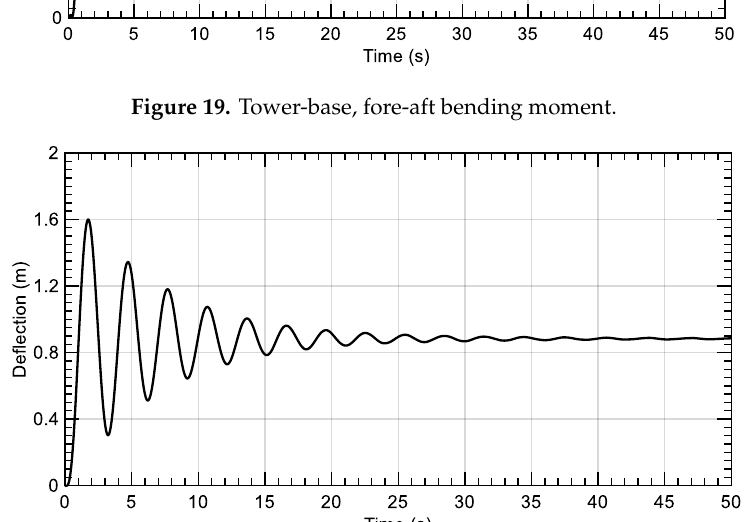
Figure 20. Tower-top, fore-aft deflection.